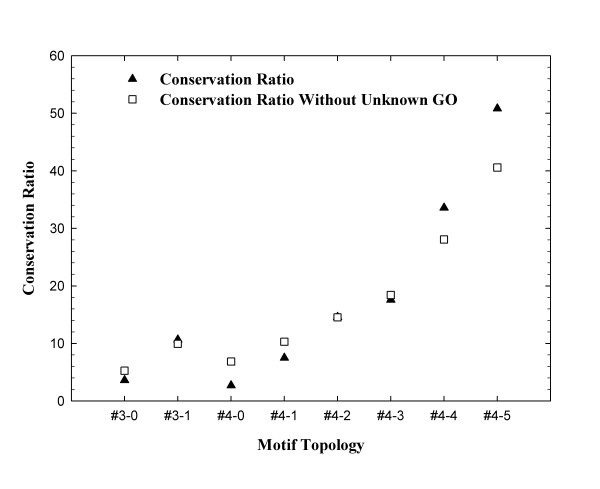
Average conservation ratio of each motif topology in the yeast PPI network. Average conservation ratio (in filled triangles and open squares) of each motif topology. If the motifs containing the protein nodes of which the GO annotations are GO:0005554 (function unknown) or have no GO annotation, the motifs were disregarded and plotted in open squares.